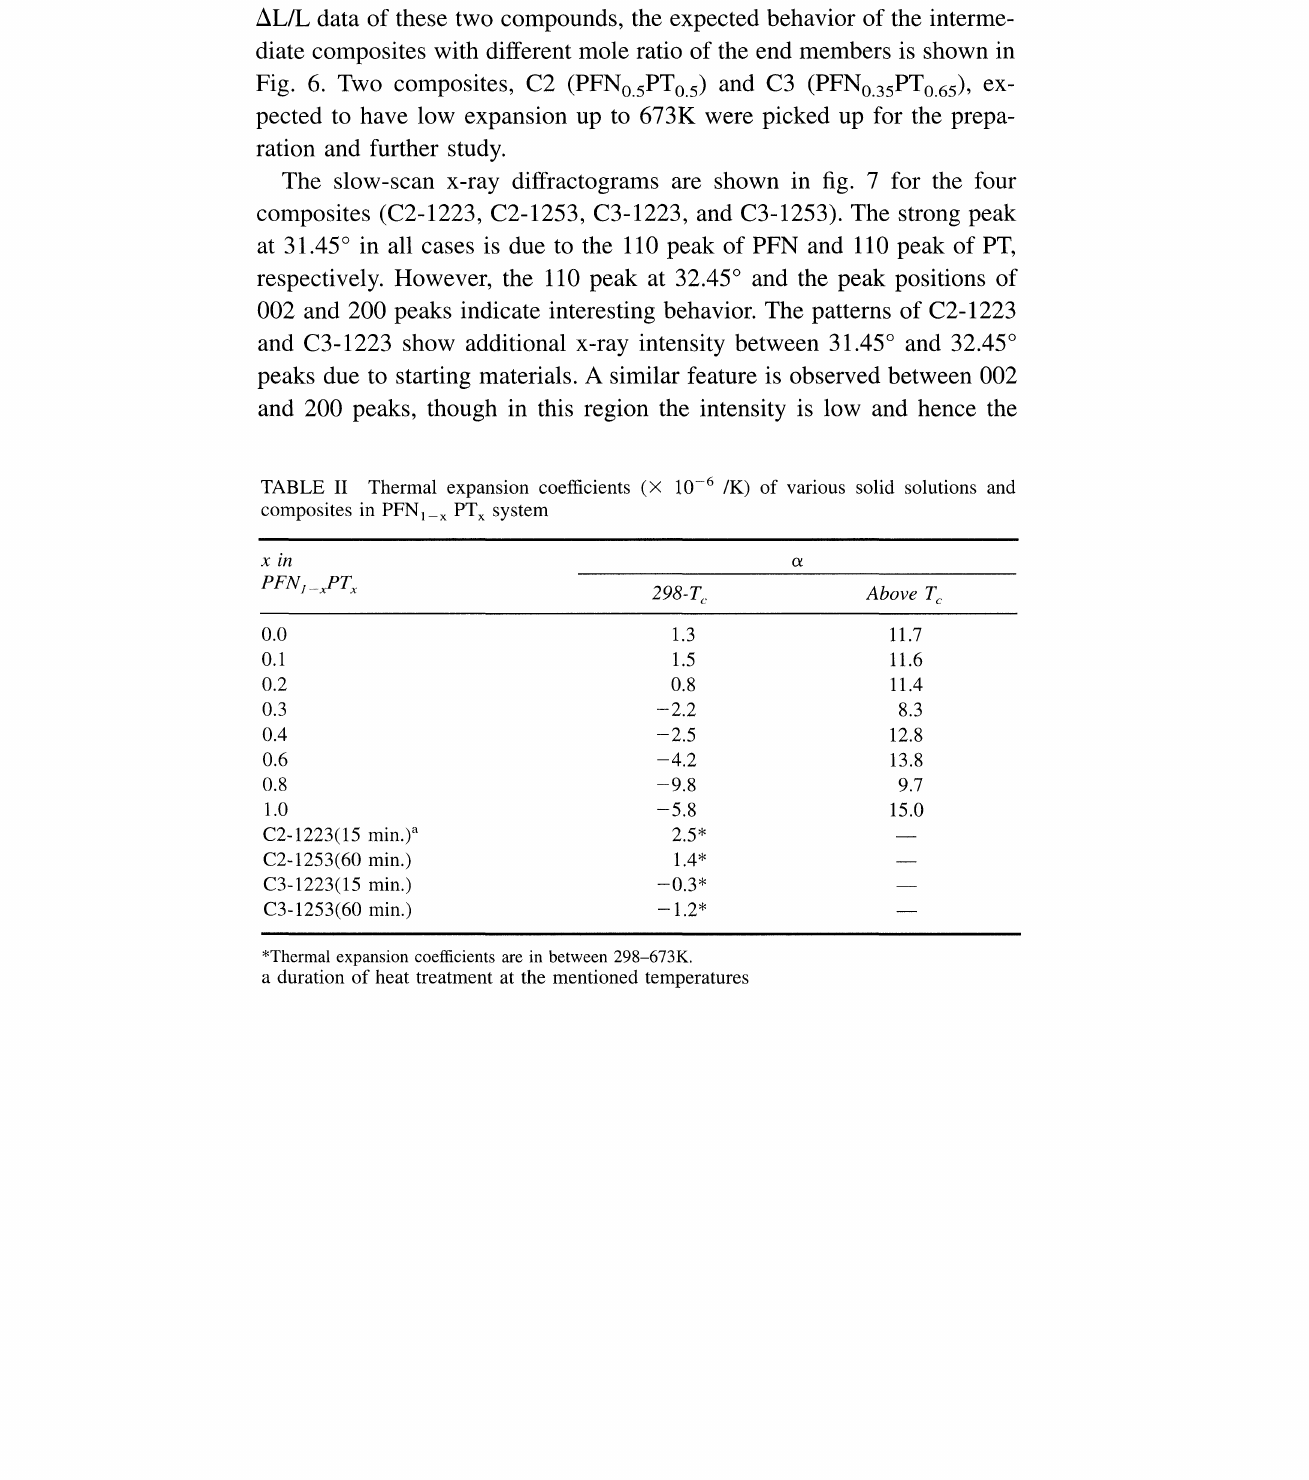
TABLE II Thermal expansion coefficients ( 10 -6 /K) of various solid solutions and composites in PFNI_x PTx system x in PFN _xPTx